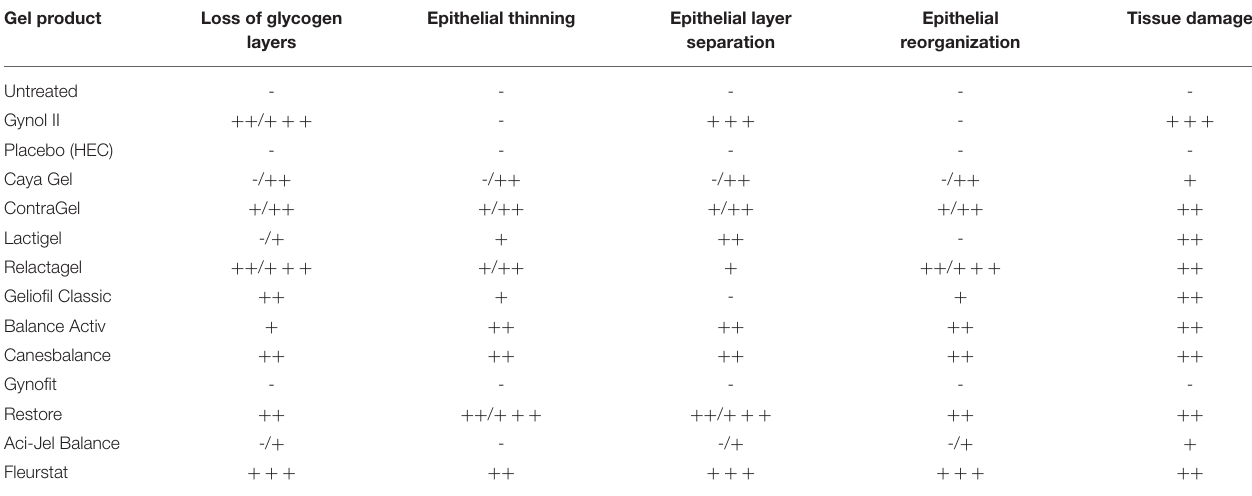
Histological examination assessed after 24h of treatment. Table show results obtained from n = 2 independent assays. Where discrepancies were observed between assays both results are shown separated by “/”.-, no effect compared to negative control; + , minimal effect; ++ , mild effect; +++ , moderate/severe effect.